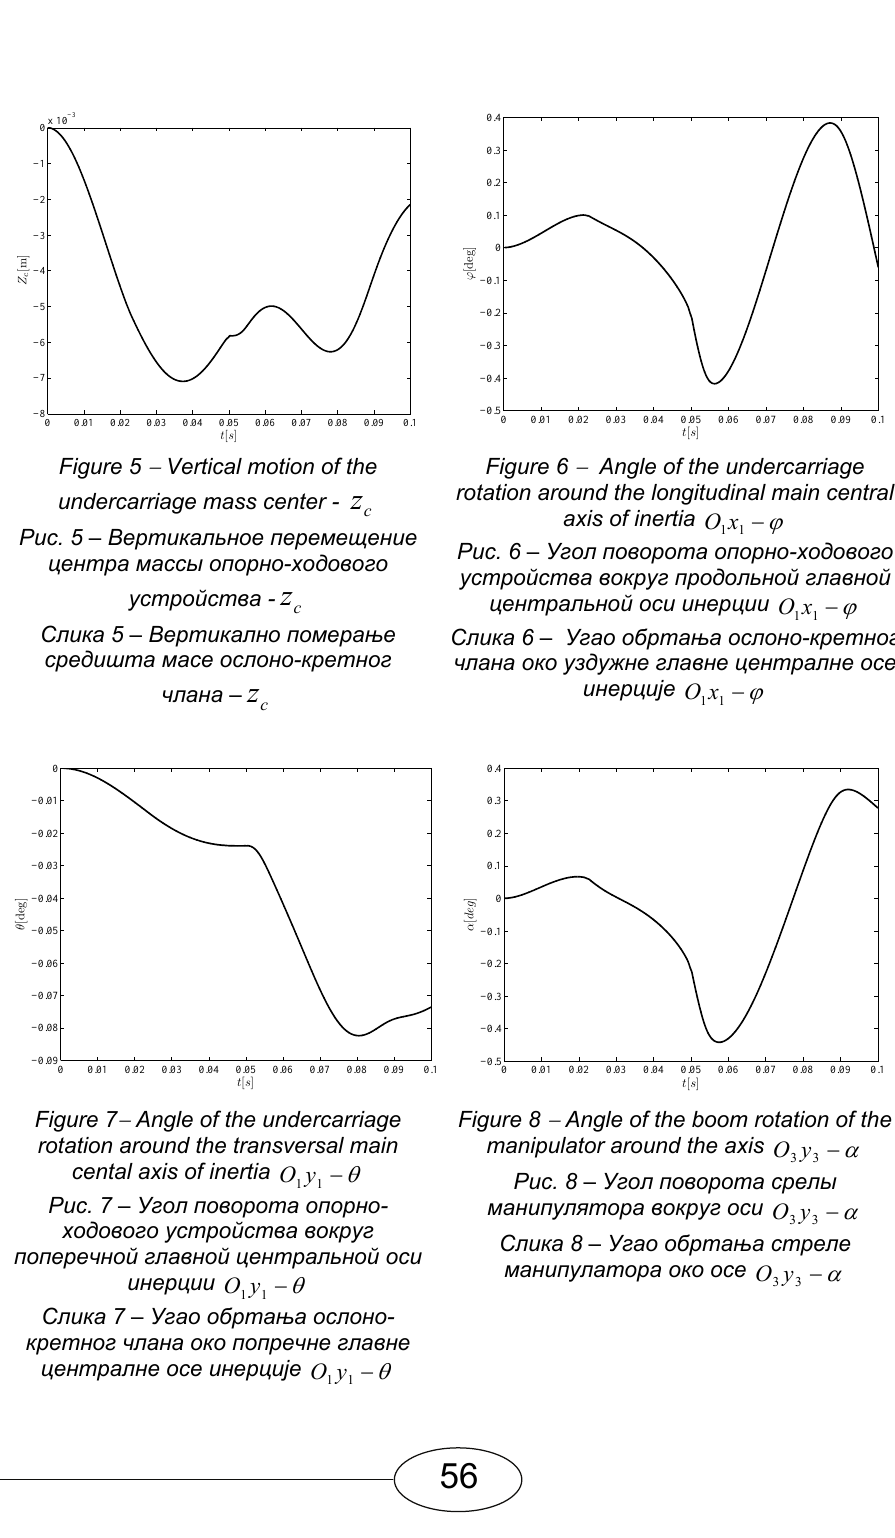
Figure 7  Angle of the undercarriage rotation around the transversal main cental axis of inertia